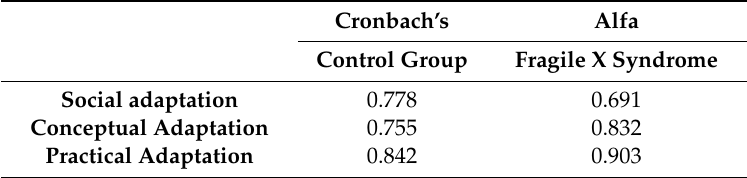
Table 2. Adaptative Behavior Assessment System- Second Edition (ABAS-II) Cronbach’s Alfa.